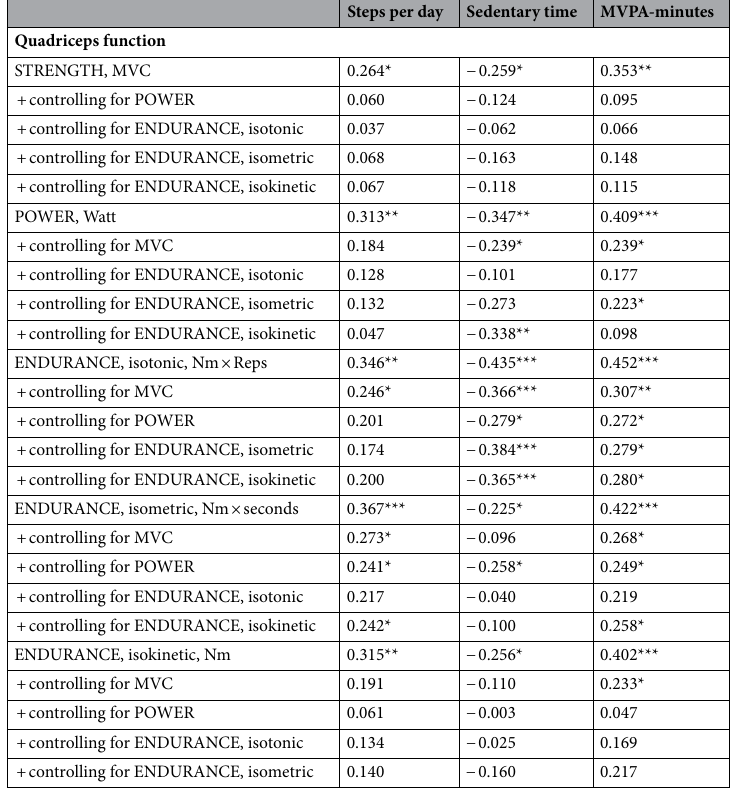
Table 2. Pearson bivariate and partial correlation (r) analysis coefficients between quadriceps functions and daily physical activity measures . MVC maximal isometric voluntary contraction, MVPA time spent in moderate to very vigorous intensity. * p < .05, ** p < .01, *** p < .001.